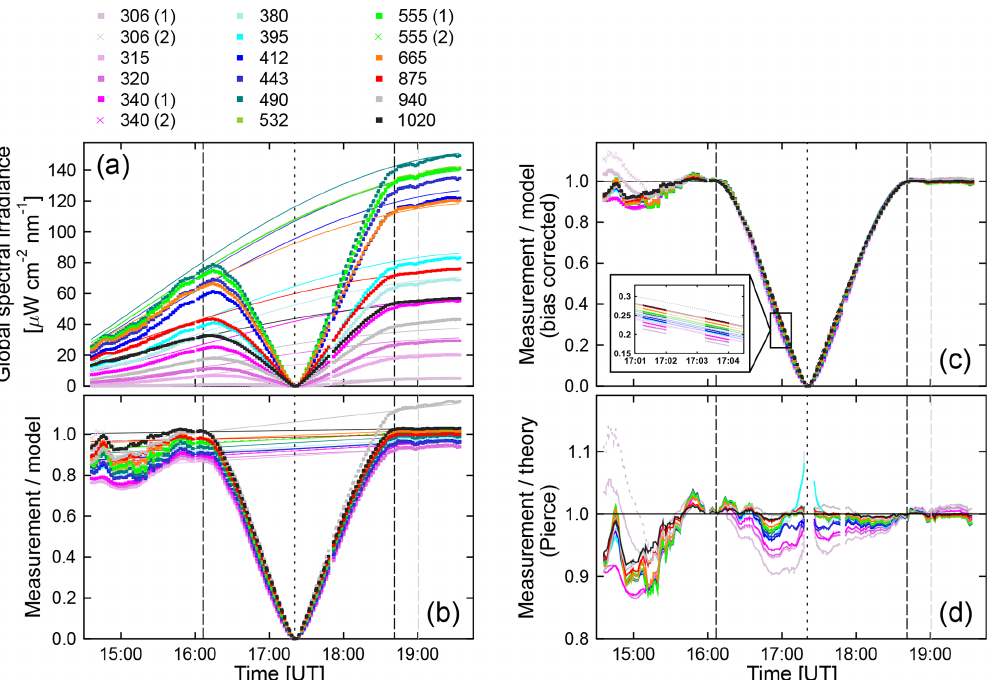
Figure 8. Comparison of the solar LD effect derived from measurements of global spectral with theoretical predictions based on the param- eterizations by Pierce. (a) Measurements of global spectral irradiance (symbols) and results of the RT calculations described in Sect. S1.1.1 of the Supplement (lines). Only every 20th data point is plotted for clarity. (b) Ratio of measurement and model (symbols). Lines connect the ratios at the times of the first and fourth contact, which are indicated by the vertical long-dashed lines. (c) Ratio of measurement and model, corrected for the bias between measurement and model (symbols). The insert shows this ratio for times between 17:01:00 and 17:04:30. The theoretical LD effect calculated with the parameterizations by Pierce is also shown and indicated with lines. (d) Ratio of bias-corrected measurements (symbols in c ) and theoretical prediction (lines in c ). Ratios for the alternative channels at 306, 340, and 555nm are indicated with broken lines and are virtually indistinguishable from those using the standard photodiode, which are indicated by solid lines. The time of maximum eclipse is indicated by the short-dashed black line. The dashed grey line specifies the time of 19:00:30 for which the AOD used by the model calculations was derived. The legend on top of the figure indicates spectral irradiance (in